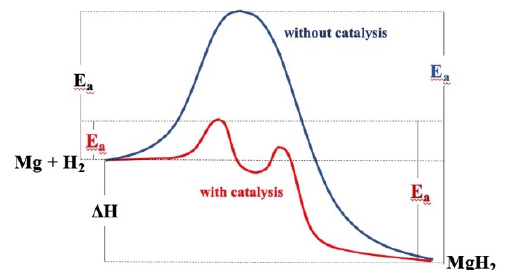
Figure 5. Representation of the kinetic barrier of the reaction and lowering the activation energy (E a ) using a catalyst. (Reprinted from ref. [52]. Copyright 2018 MDPI.).